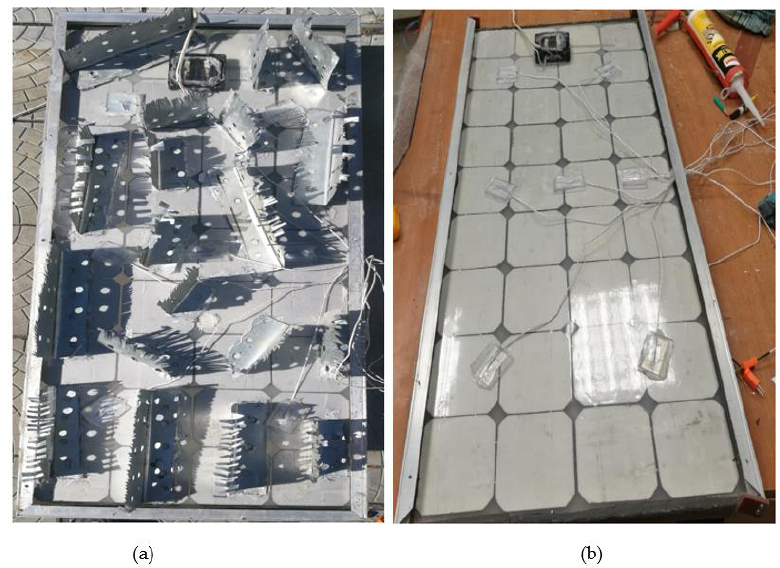
Figure 3. ( a ) Modified panel with aluminum fins ( b ) referenced module.